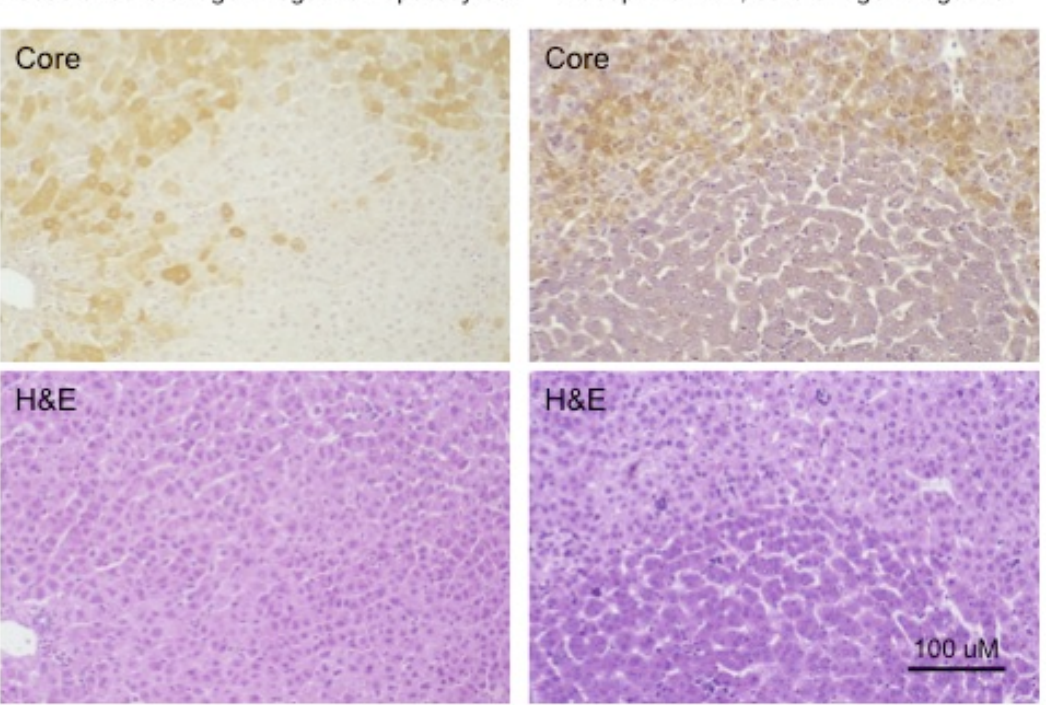
Figure 4. Foci of normal and basophilic, woodchuck hepatitis-virus (WHV) core antigen-negative hepatocytes in chronically WHV-infected woodchuck liver. The left-hand panels are consecutive sections of WHV-infected liver, either immune-peroxidase stained using antibodies to WHV core antigen (top) or Hematoxylin and Eosin (H&E) stained (bottom), showing a focus of histologically normal, WHV core antigen-negative hepatocytes. The right-hand panels are similar consecutive sections showing a basophilic focus of altered hepatocytes (FAH) that are also WHV core antigen-negative. Figure adapted and reproduced with permission from reference [91], Xu et al., Virology, published by Elsevier, 2007.